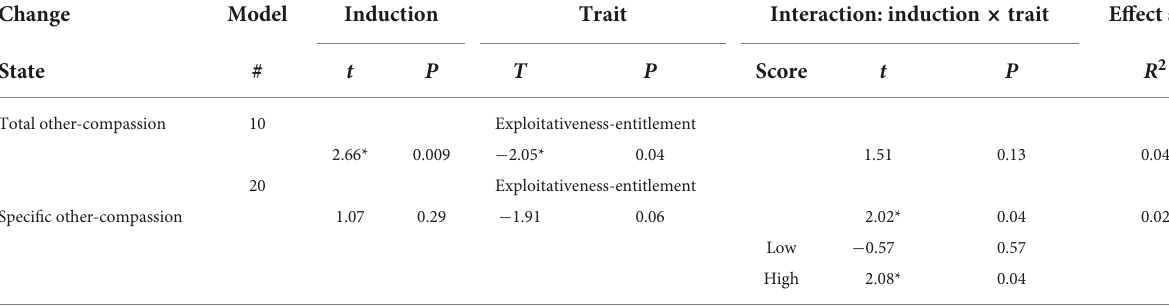
TABLE 2 Significant moderation regression analyses for grandiose narcissistic